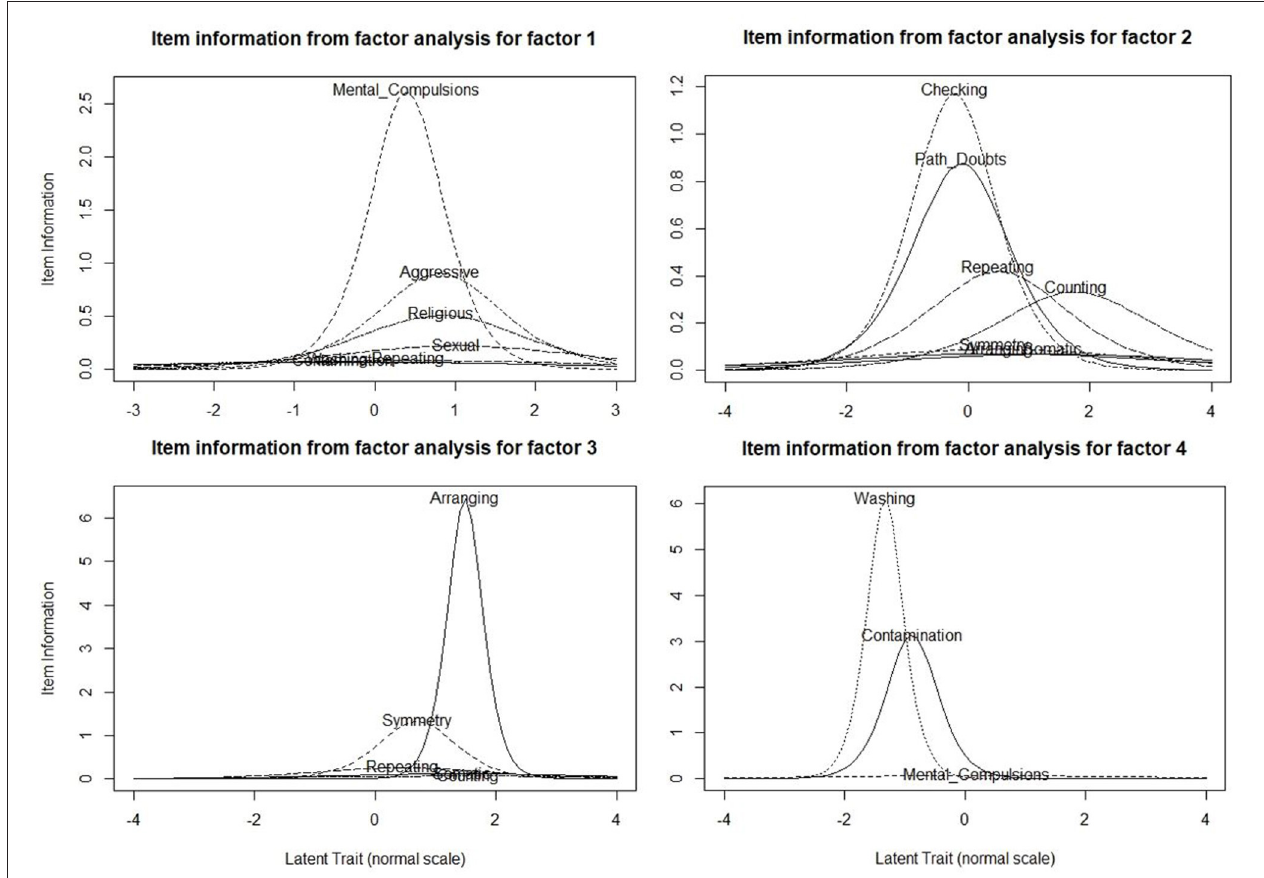
FIGURE 2 | Item Information Curve (IIC) Plots of the Multi-dimensional Item Response Theory analysis done with the Yale-Brown Obsessive-Compulsive Checklist Items ( N = 330). These plots represent the item information curves (IICs) for the items that are loaded within each factor. The x-axes represent the “difficulty” parameter (lesser “difficulty” means greater likelihood of the subject endorsing this item), and the y-axes represent the “discrimination” parameter. IICs with high peaks and relatively narrow spread indicate high discrimination, or high specificity of the item for that particular factor.